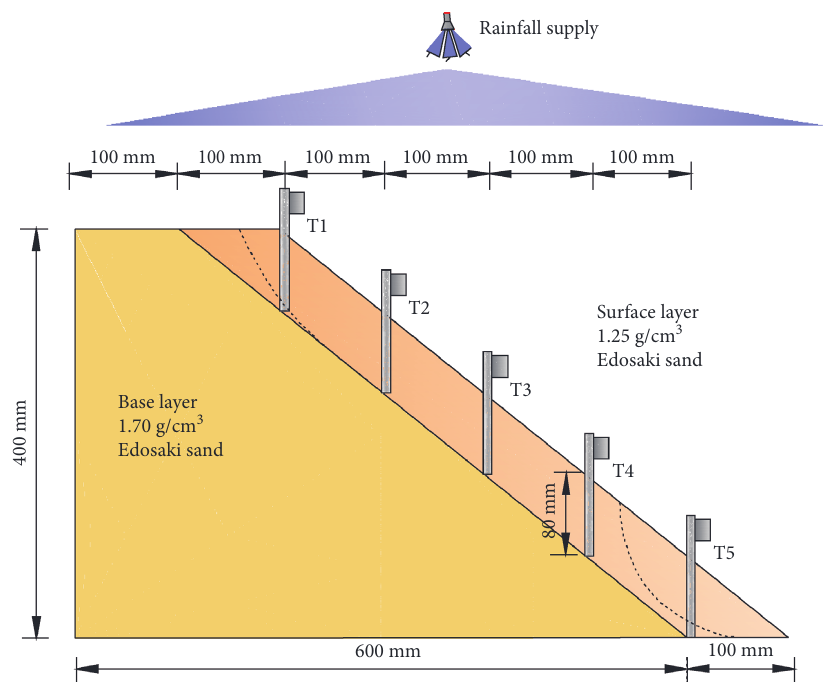
Figure 14: The cross-section of the slope model and the setup of apparatuses in the laboratory test.